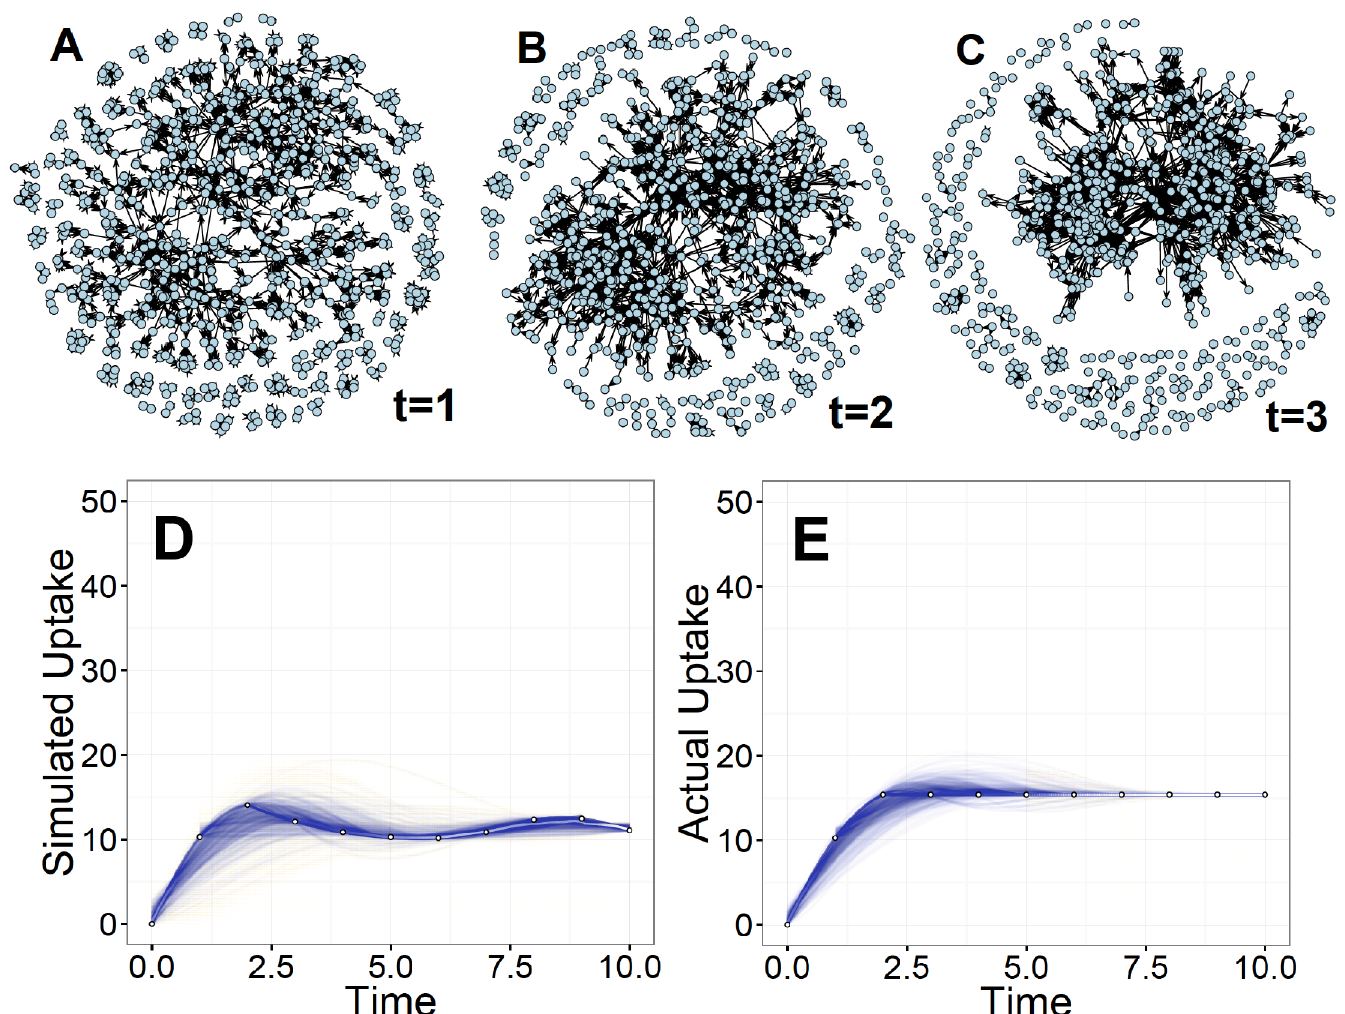
Fig 6. Simulated influence and percent of people adopting MF in a sample village. A shows the influence structure for this village at t = 1. B shows the influence structure at t = 2. C shows the influence structure at t = 3. D shows the simulated MF uptake in this village over time. E shows the actual observed MF uptake over time.